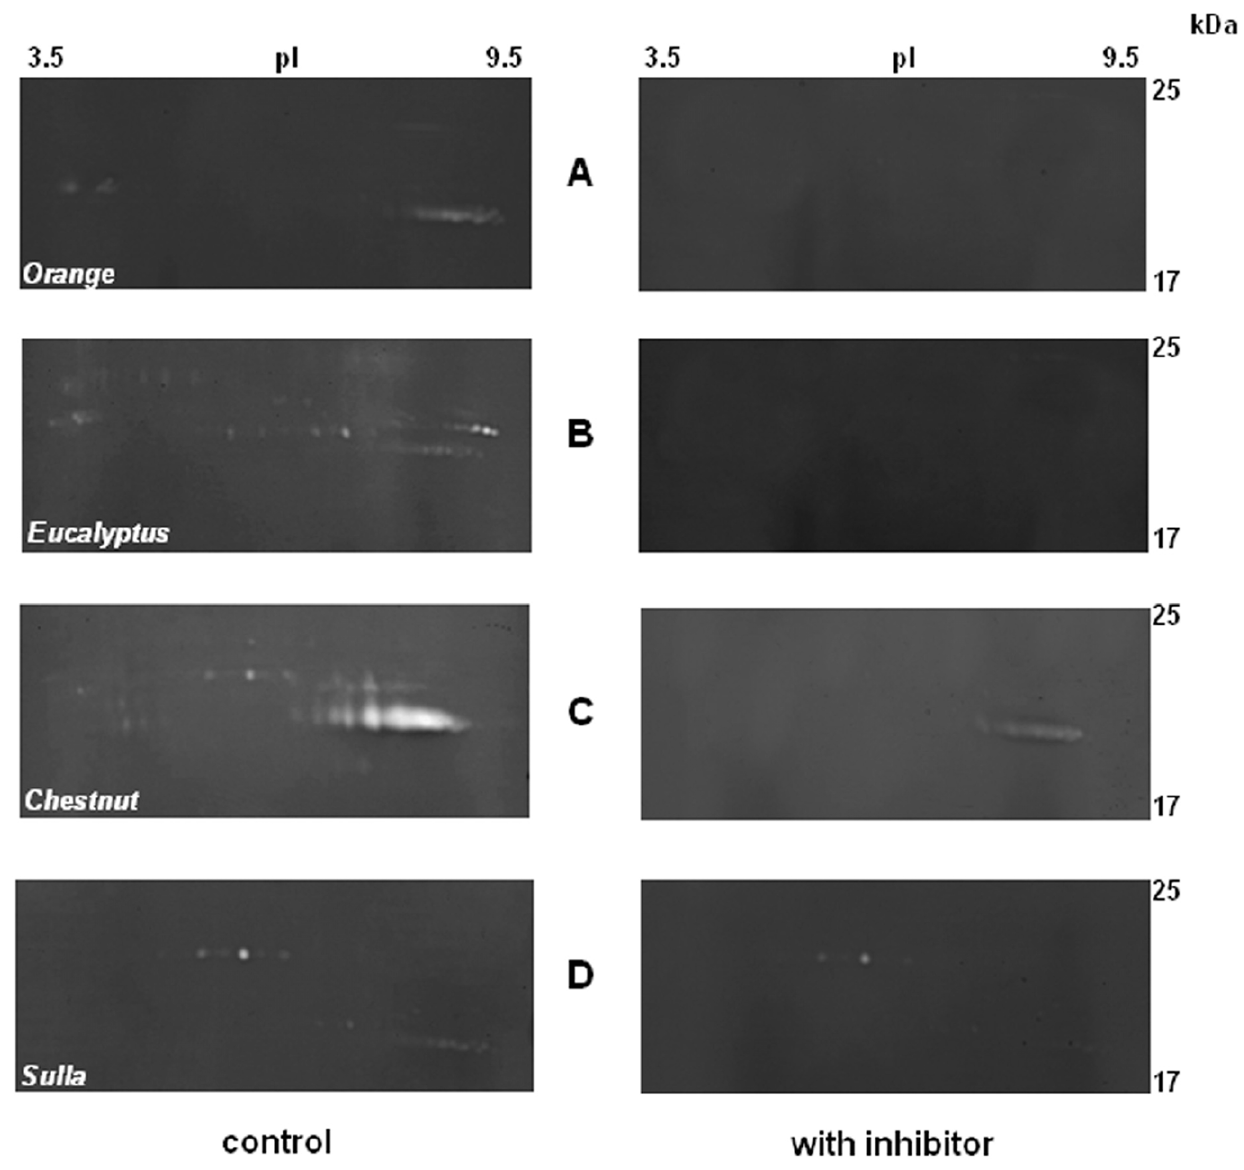
Figure 5. Specific inhibition by PMSF of the proteolytic activities present in honey MT1 extracts. 2-D zymography of the honey extracts, in the absence (control, left panels) and in the presence (right panels) of 1.5 mM PMSF, inhibitor of serine proteases. Gels: 1 ( orange ), 2 ( eucalyptus ), 3 ( chestnut ) and 4 ( sulla ).Only the regions of the gels with isoelectric point between pH 3.5–9.5 and molecular mass between 17–25 kDa are shown.